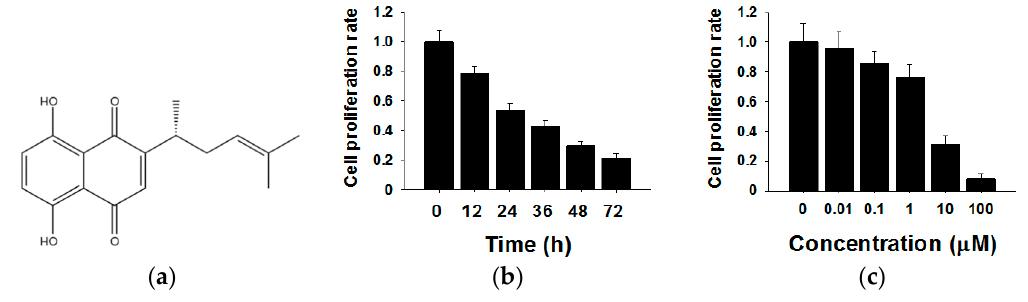
Figure 1. Effects of shikonin on the proliferation of MCF-7 cells. ( a ) The chemical structure of shikonin; ( b ) Shikonin decreases cell proliferation in a time-dependent manner; ( c ) Shikonin decreases cell proliferation in a dose-dependent manner. Data are given as a mean ± SD of individual experiments with three plates for each experiment.